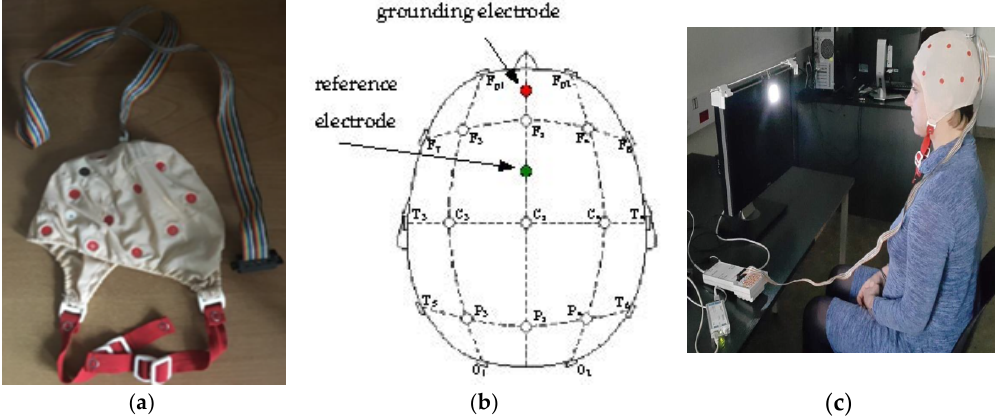
Figure 6. ( a ) cap for EEG of Deymed Diagnostic company; ( b ) 19 chlorine silver, reference and grounding electrodes; ( c ) subject (man-operator) being examined.